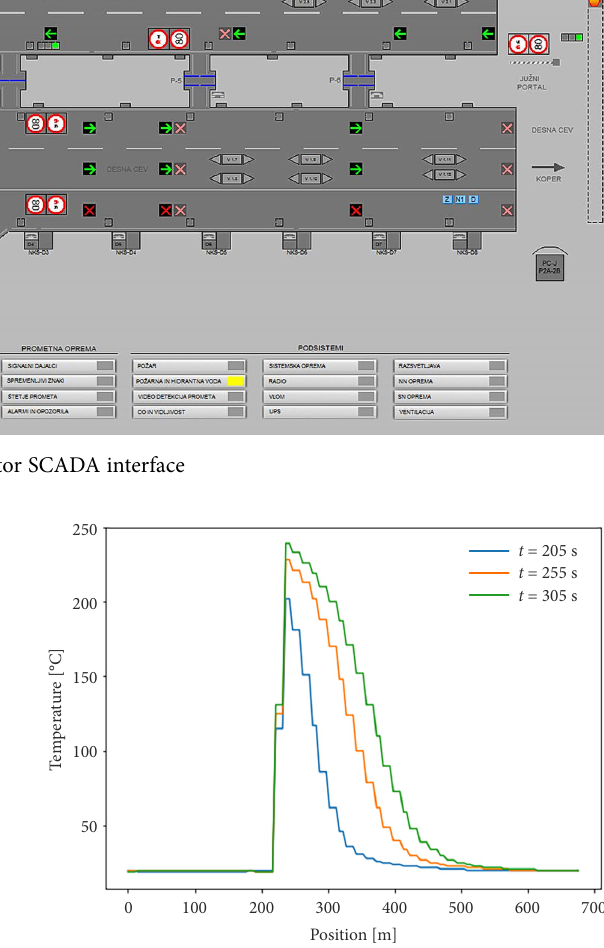
Figure 12. Air temperature profile during 50 MW fire